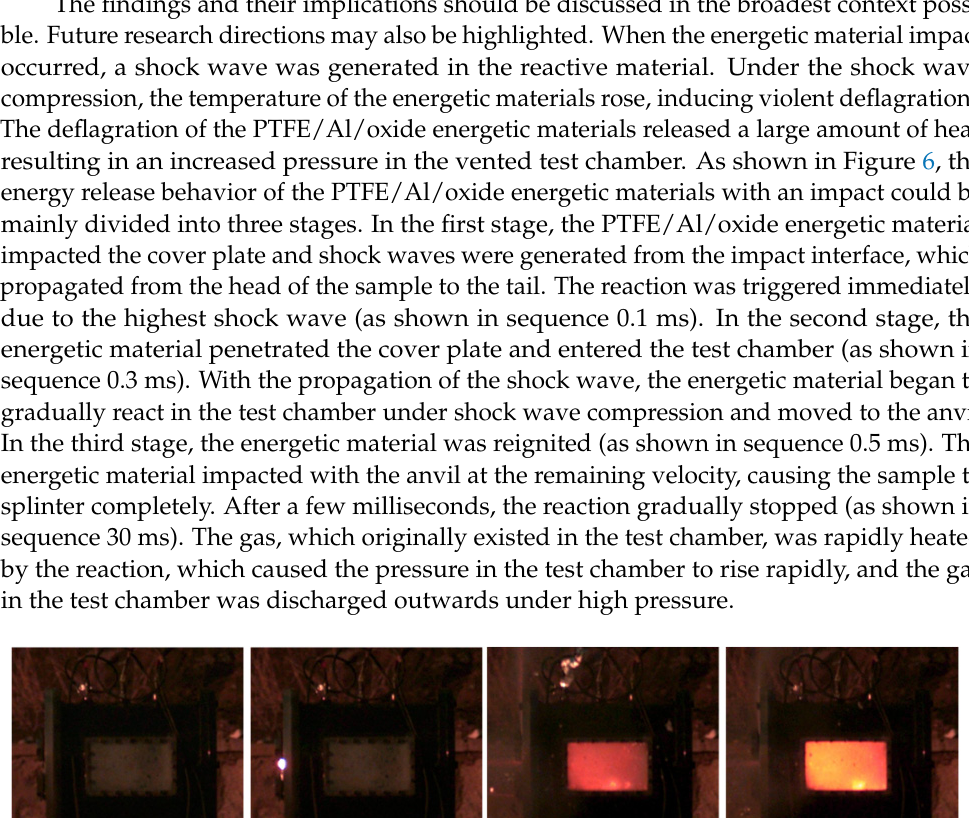
2 O 3 , v = 944.3 m/s) energy release